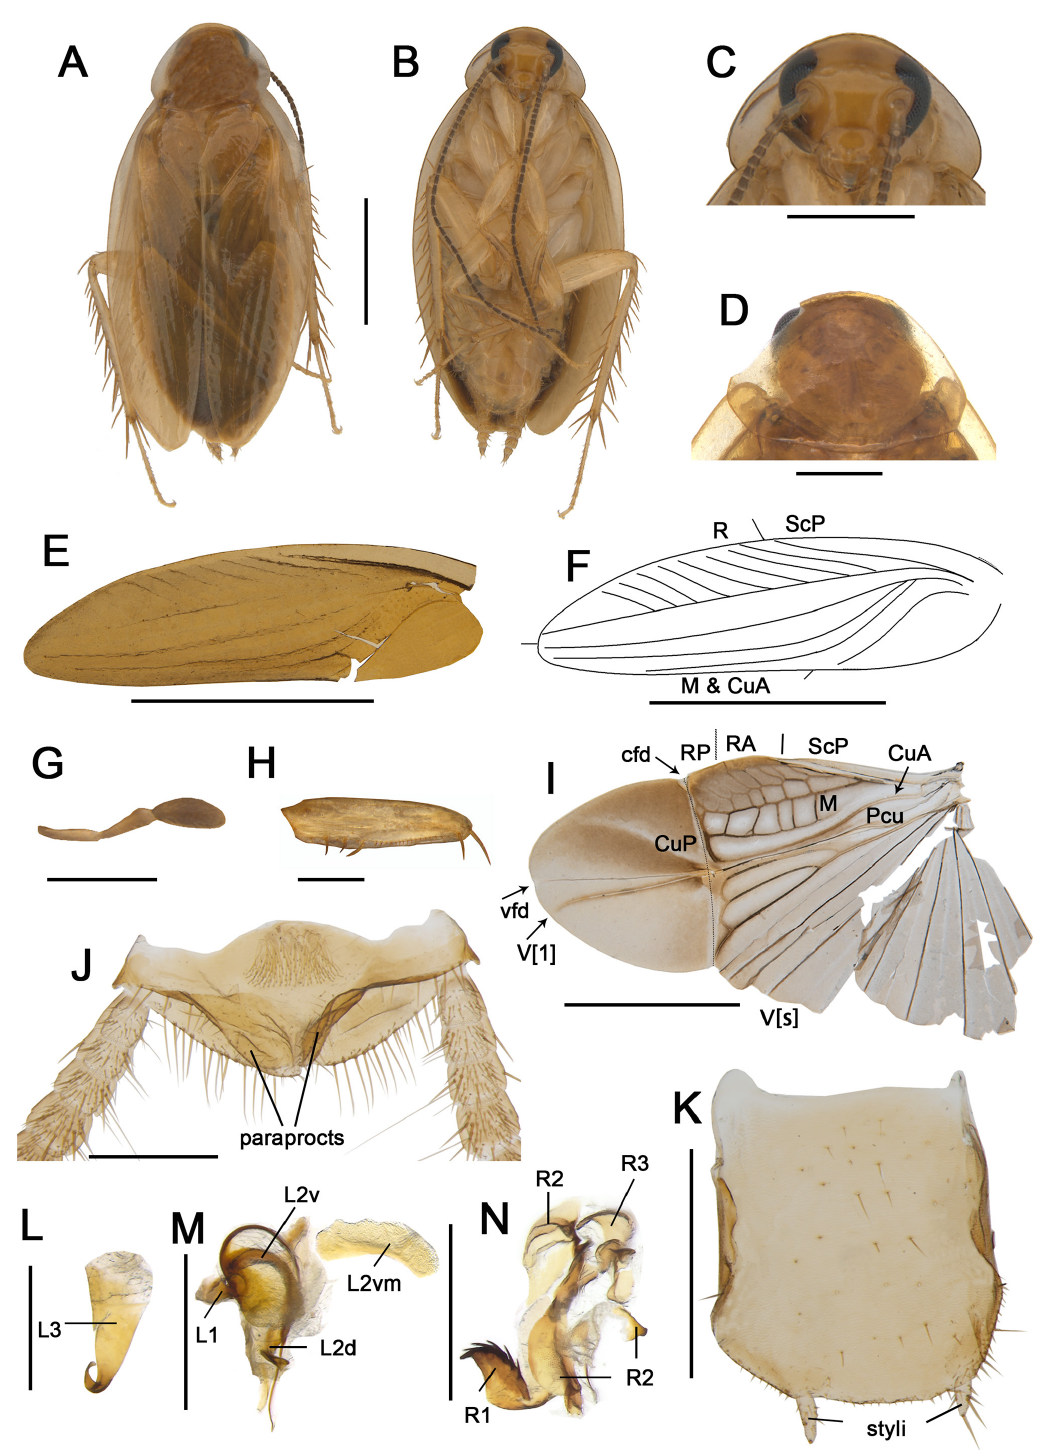
Fig. 2. Anaplecta corneola Deng & Che sp. nov., holotype, ♂ (SWU). A . Habitus, dorsal view. B . Habitus, ventral view. C . Head, ventral view. D . Pronotum, dorsal view. E . Tegmina. F . Tegmina vein. G . Maxillary palp. H . Front femur, ventral view. I . Wings. J . Supra-anal plate, dorsal view. K . Subgenital plate, ventral view. L . Hook, ventral view. M . Left phallomere, ventral view. N . Right phallomere, ventral view. Scale bars: A–B, E–F, I = 2 mm; C, G–H = 1 mm; D, J–K, M–N = 0.5 mm; L = 0.25